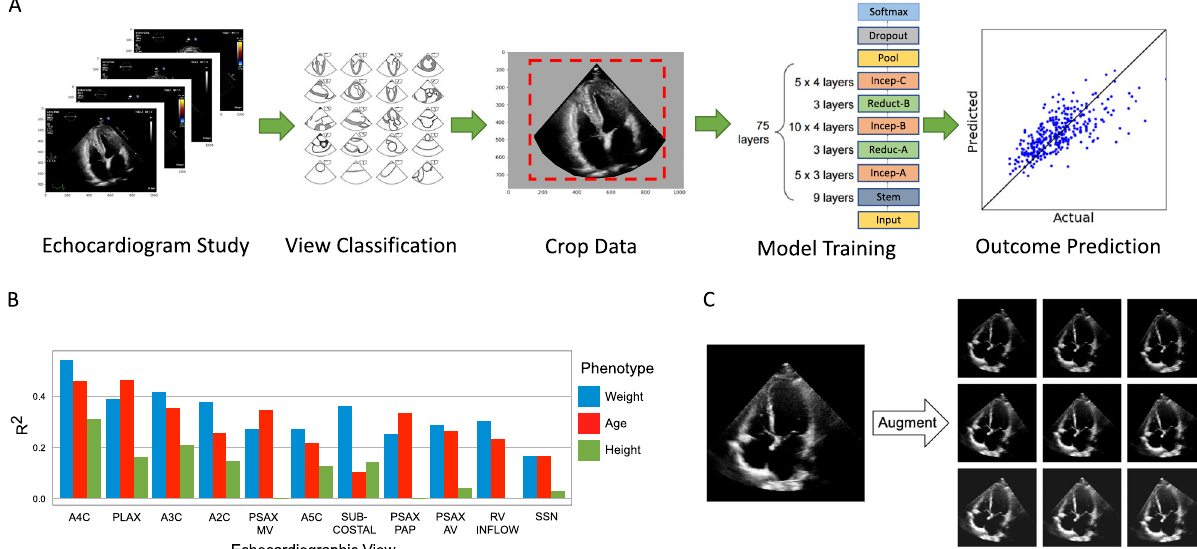
Fig. 1 EchoNet machine learning pipeline for outcome prediction. a EchoNet work fl ow for image selection, cleaning, and model training. b Comparison of model performance with different cardiac views as input. c Examples of data augmentation. The original frame is rotated (left to right) and its intensity is increase (top to bottom) as